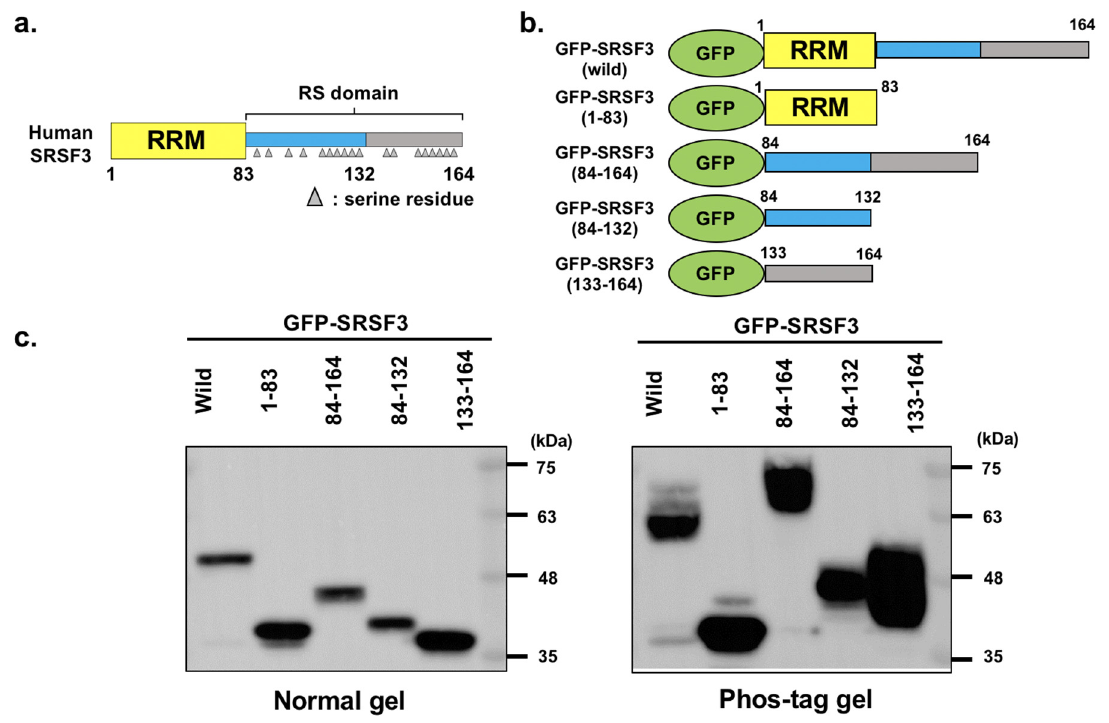
Figure 1. SRSF3 structure and the estimation of SRSF3 fragments. ( a ) SRSF3 structure indicating the position of RNA-recognition motif (RRM), RS domain (the first half of RS domain containing RS repeats is shown in the blue box, the latter half of RS domain containing RS repeats is shown in the gray box), and serine residues (gray triangles). ( b ) Structure of SRSF3 and fragment mutants. ( c ) Expression of transfected GFP-SRSF3 and fragment mutants was detected by western blotting with an anti-GFP antibody (left panel). Phosphorylation status of SRSF3 and mutants was analyzed with phos-tag gel (right panel).